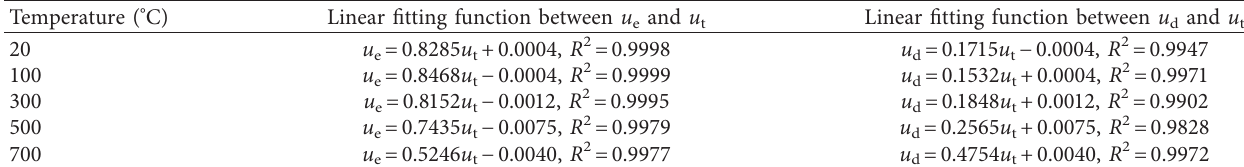
Figure 4: Relationships between the three energy densities of pre-heated granite specimens (the linear fitting results of u e and u t (a) and u d and u t (b) are shown) [46]. Table 1: Linear fitting equations between u e and u t and u d and u t of pre-heated granite specimens [46]. Temperature ( ° C) Linear fitting function between u e and u t Linear fitting function between u d and u